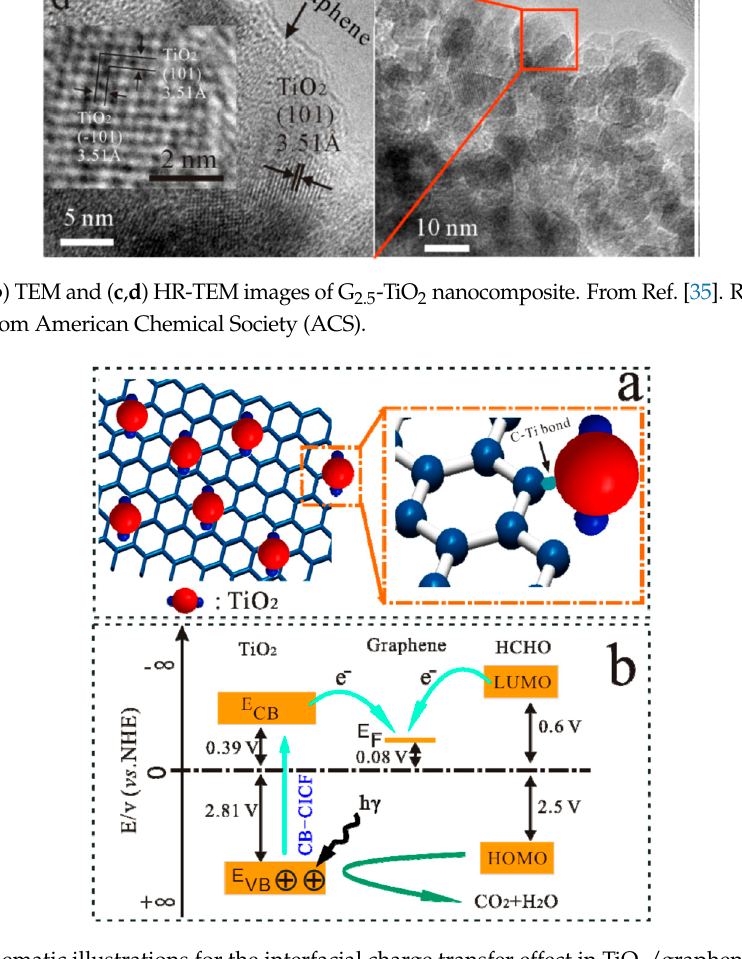
Figure 2. Schematic illustrations for the interfacial charge transfer effect in TiO 2 /graphene composites: ( a ) the chemical bonding between TiO 2 nanoparticles and graphene nanosheets; ( b ) the reported energy level of the valence band (VB) and conduction band (CB) vs. NHE (normal hydrogen electrode). From Ref. [35]. Reprinted with permission from ACS.